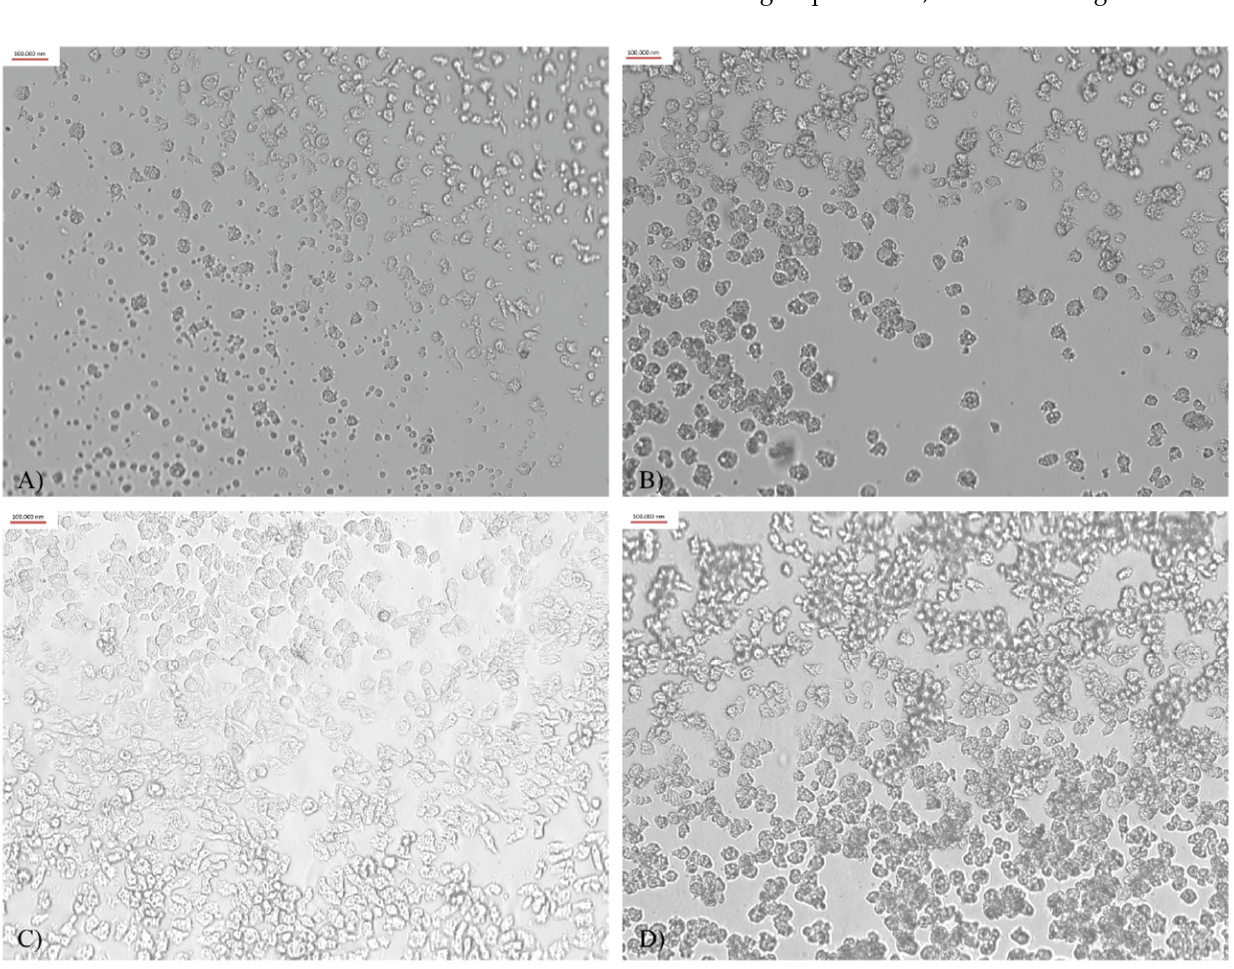
Figure 1. Trophozoite adhesion to the contact lens surface after 90-min incubation ( × 400 magnifica- tion): ( A ) FDA group 1; ( B ) FDA group 2; ( C ) FDA group 3; ( D ) FDA group 4.